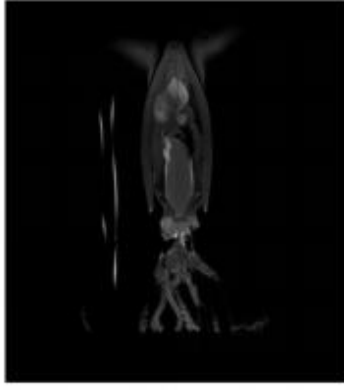
Figure 1. One of the MRI scan